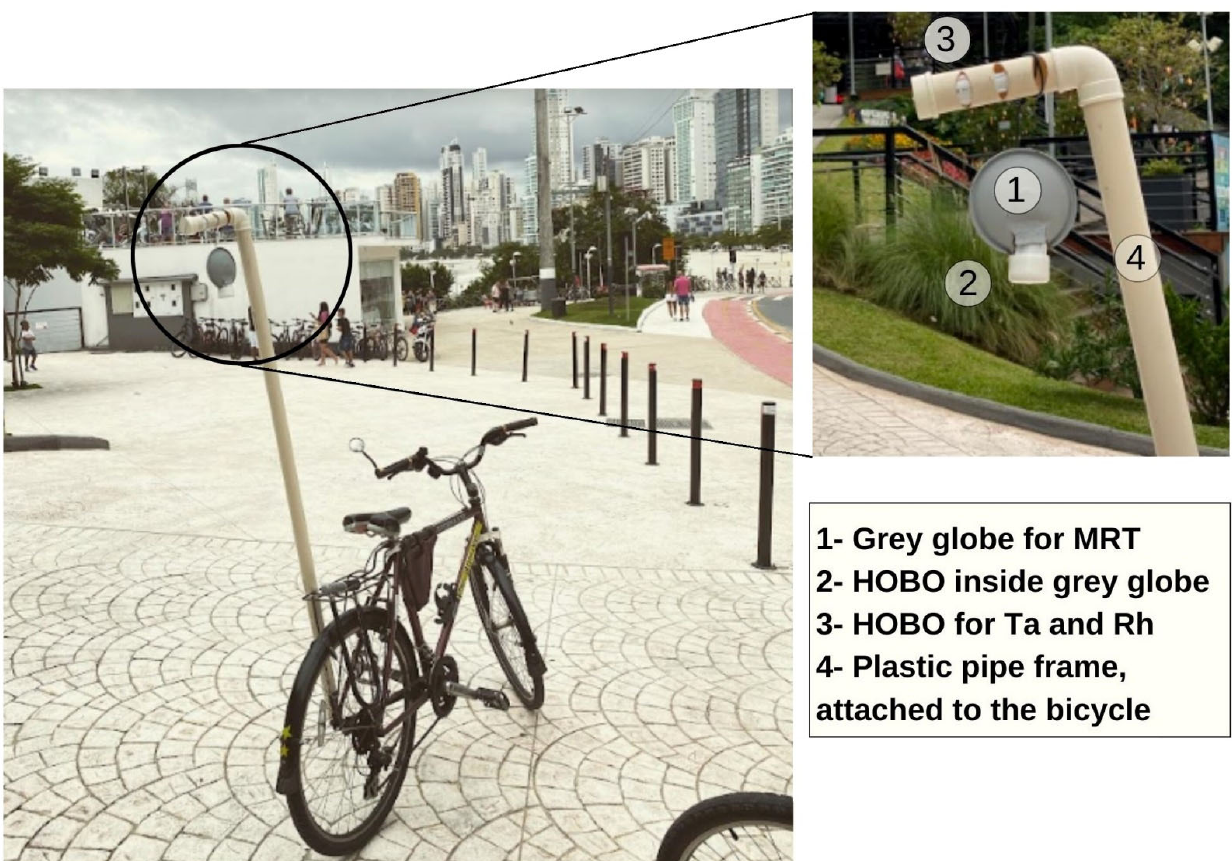
Figure 6. Dataloggers attached to the bicycle. Source: Authors (2022).